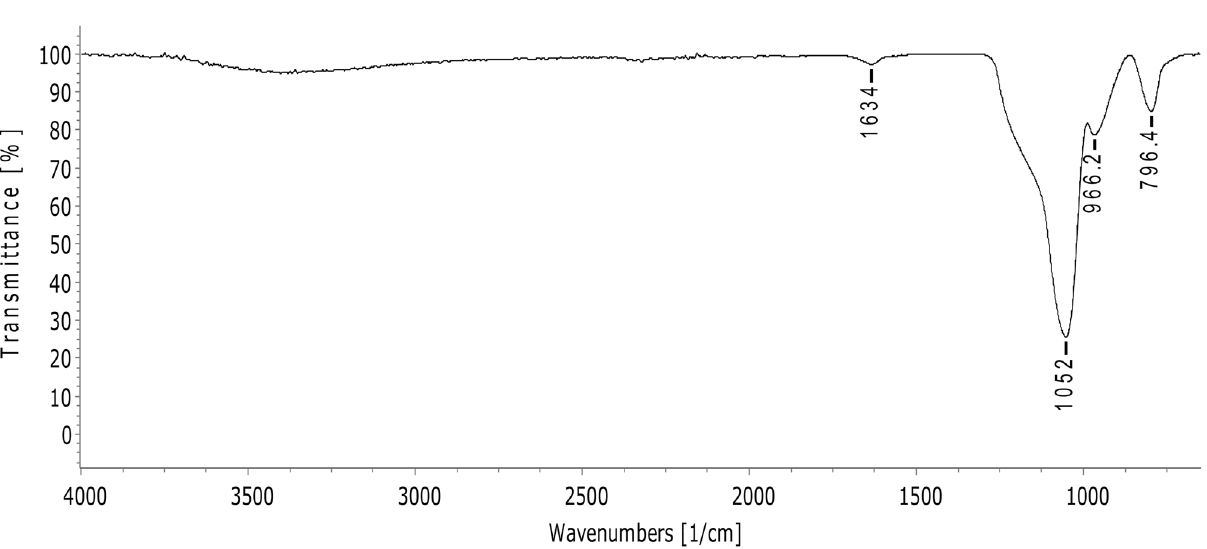
Figure 5. FT-IR spectrum of silica nanoparticles synthesized from UKMRC-8 rice husk